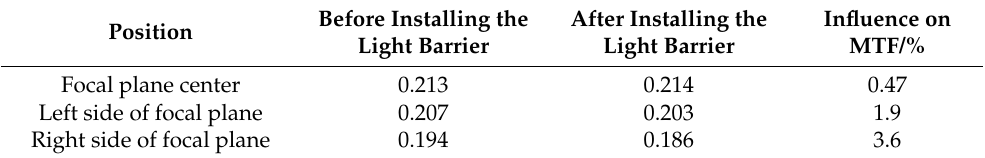
Figure 14. Test curve of MTF and target imaging fringe. ( a ) MTF test results before installing the light barrier of the third mirror; ( b ) MTF test results after installing the light barrier of the third mirror. Table 10. MTF test results of Panchromatic band. Position